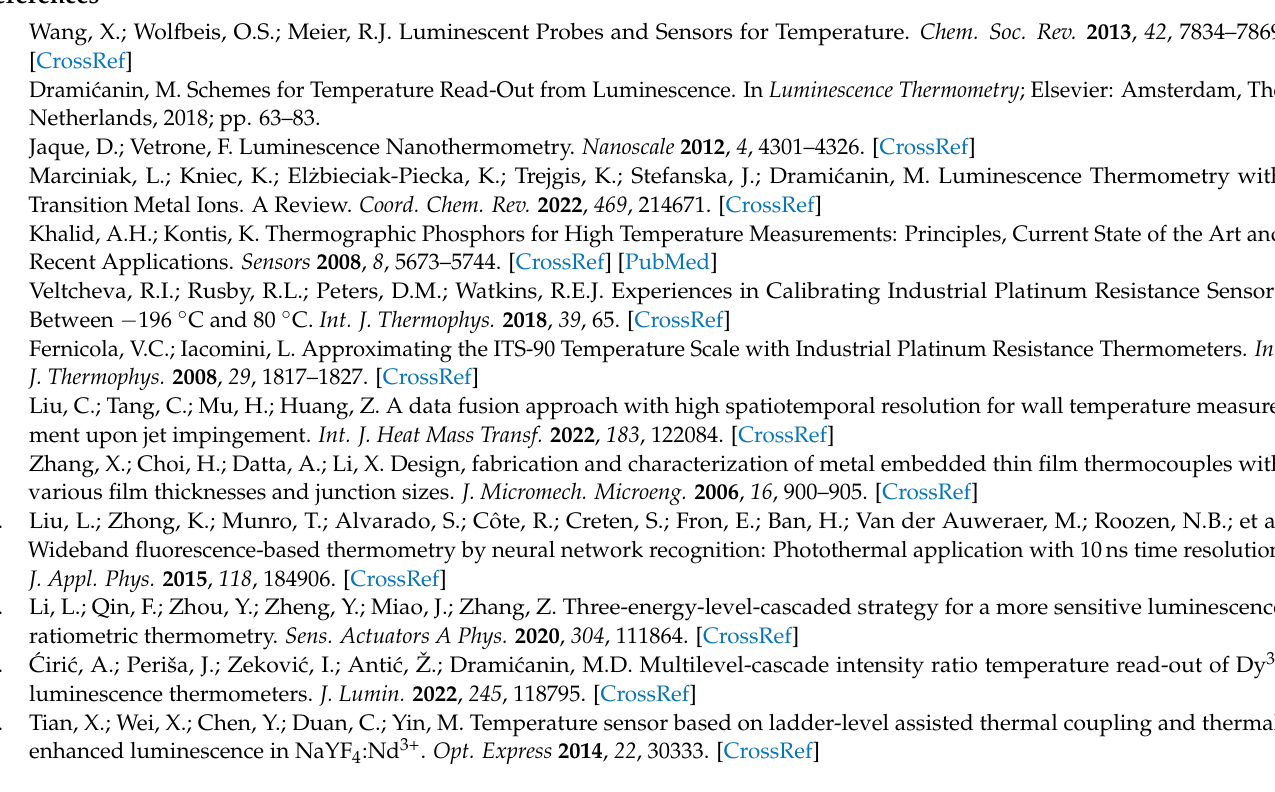
Figure S2: Powder X-ray diffractogram of Ca 6 BaP 4 O 17 :(0.75%)Mn 5+ near-infrared phosphor powder, Figure S3: The removal of background emission from Stokes and anti-Stokes emission